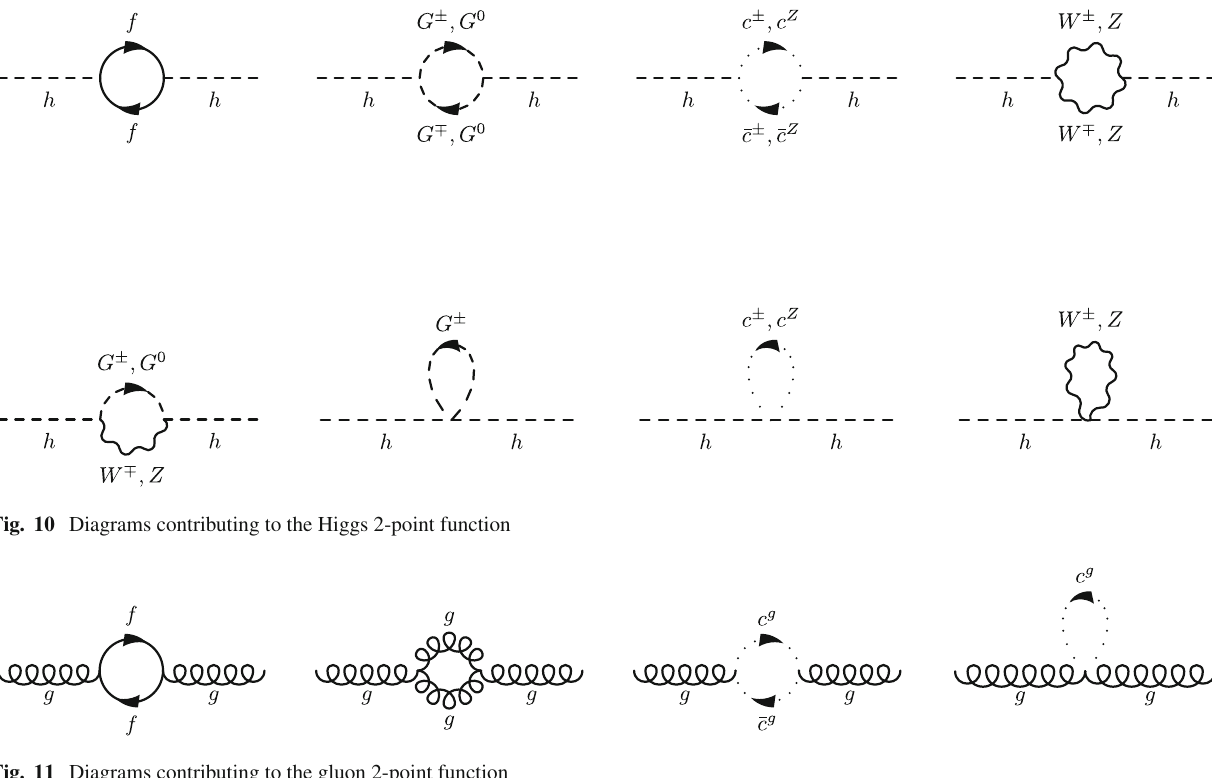
Fig. 11 Diagrams contributing to the gluon 2-point function